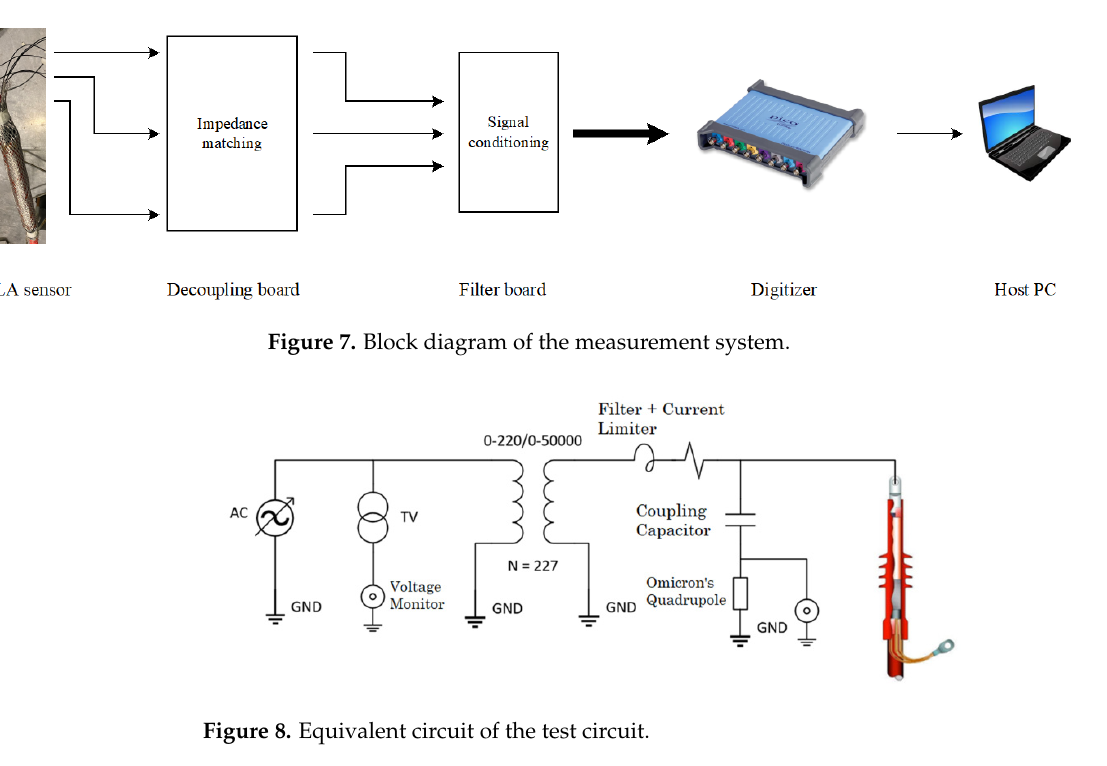
Figure 7. Block diagram of the measurement system.